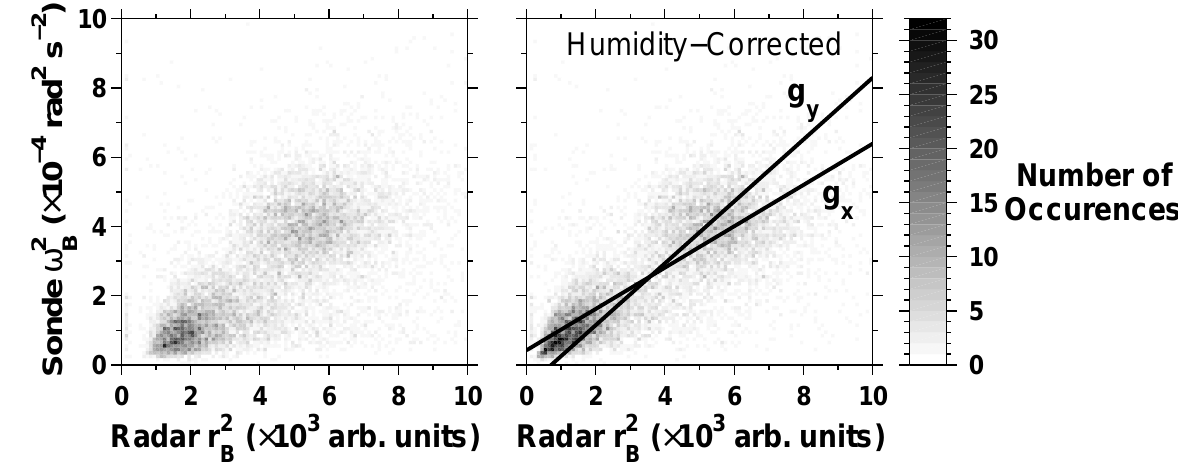
Fig. 1. The relationship between radiosonde-derived values of ω 2 100 grid, with divisions of 0.1 × 10 − 4 rad 2 s − 2 along the y-axis and of 0.1 × 10 3 arbitrary r 2 the number of data points falling within each cell. The values of r 2 labelled g x and g y represent the best fits from the regression of y on x and vice versa.